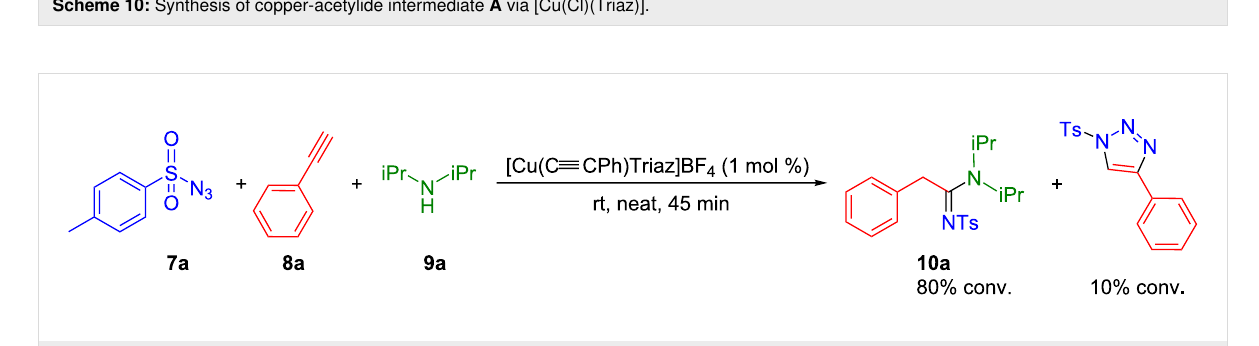
Scheme 11: Catalytic reaction involving copper-acetylide complex A